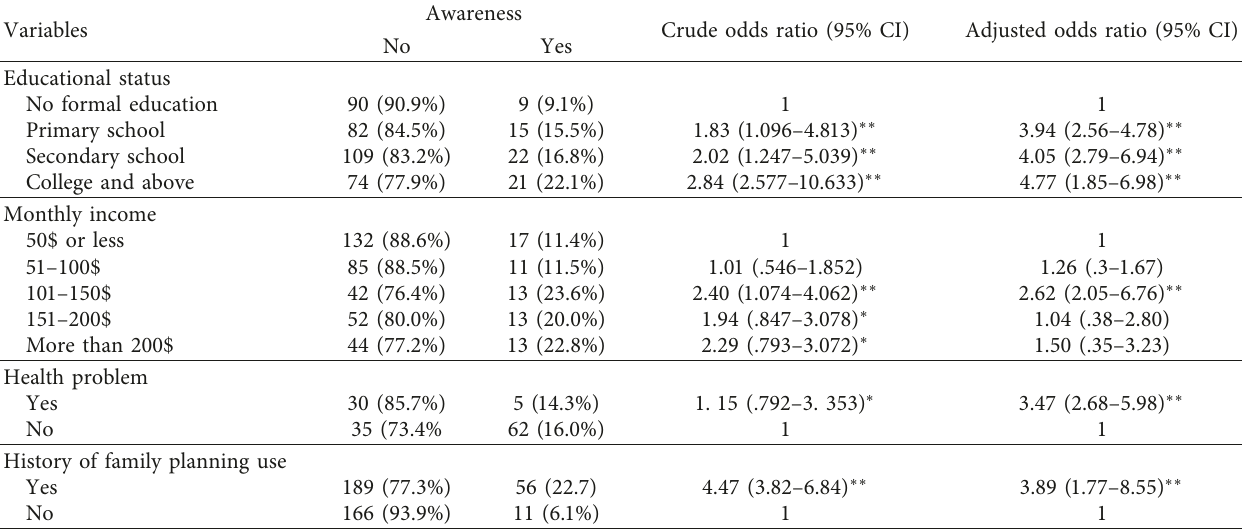
Table 4: Factors associated with women’s awareness on preconception folic acid supplementation in Adet, Gojjam, Northwestern Ethiopia, 2016 ( n �